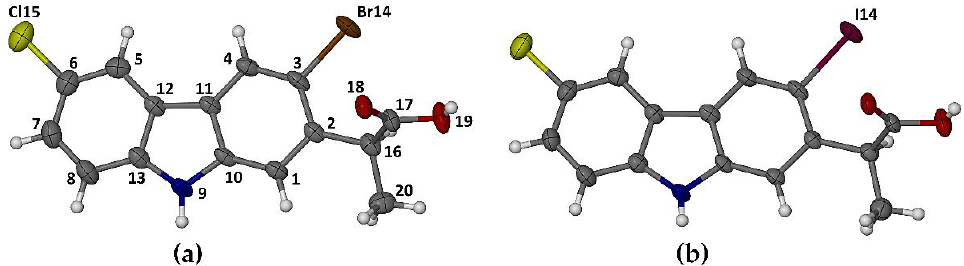
Figure 2. The molecular structures of 2 ( a ) and 3 ( b ), with non-hydrogen atoms drawn as thermal ellipsoids at the 50% probability level. The atomic numbering scheme shown in ( a ) was used for both molecules.